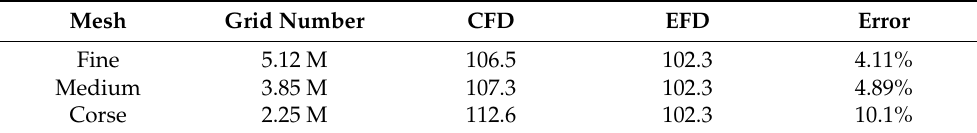
Table 4. Comparison of submarine resistance between the calculation and experiment results. Mesh Grid Number CFD EFD Error